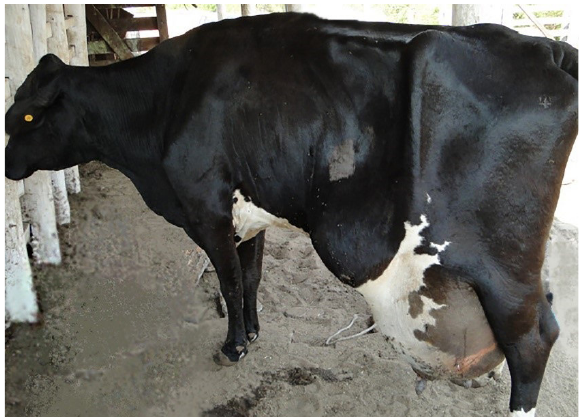
Figure 1. Cow with increased volume of the udder and ventrolateral portion of the left abdomen.